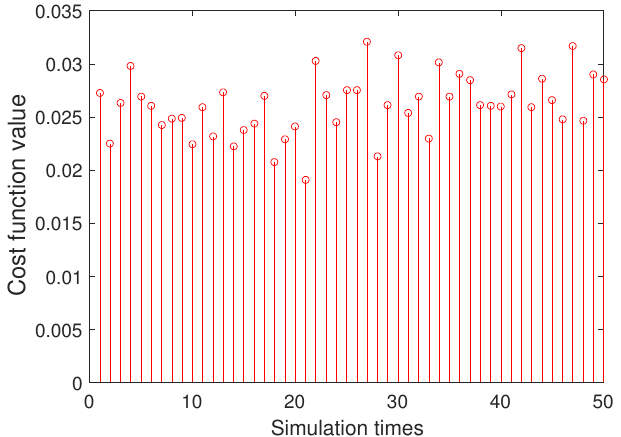
Figure 6. 50 simulation results of cost function for basic BAS algorithm.